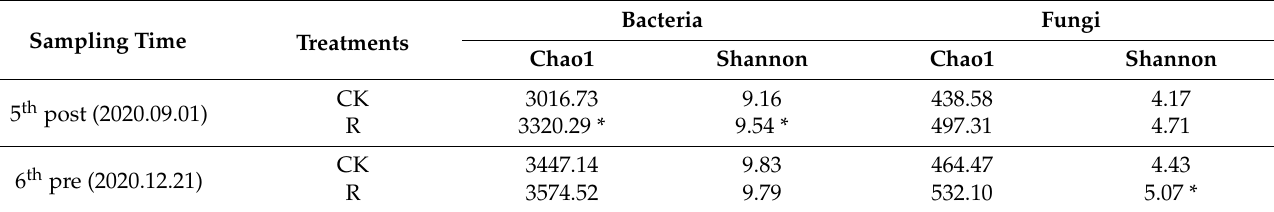
Table 3. The alpha diversity of the microbial communities. Bacteria Fungi Sampling Time Treatments Chao1 Shannon Chao1